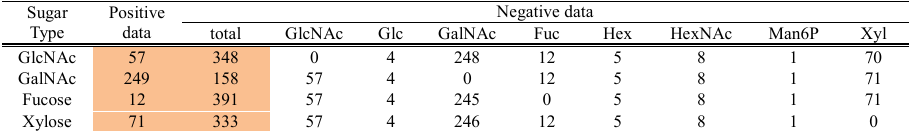
Table 1. O -glycosylated protein representative dataset extracted from the UniProt